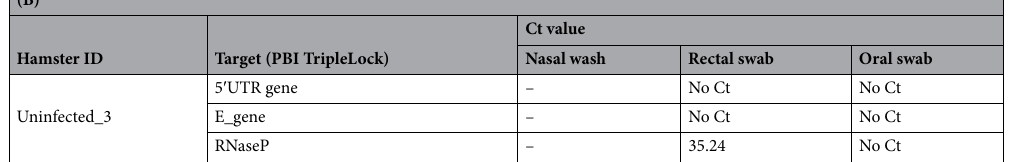
Table 5. Evaluation of clinical performance Biomeme and Precision Biomonitoring TripleLock SARS-CoV-2 assays with hamster samples. The M1 Sample Prep Cartridge Kit for RNA 2.0 was used to extract RNA from the nasal wash, rectal swab, and oral swab samples from SARS-CoV-2-inoculated hamster on days 2 (#81–83) and 5 (#84–86) post-inoculation. Following RNA extraction, the extracts were tested with Biomeme (A) and Precision Biomonitoring TripleLock SARS-CoV-2 (B) assays on Franklin three9. *The RNA Process Control may not amplify (No Ct) when the two SARS-CoV-2 gene signals are very